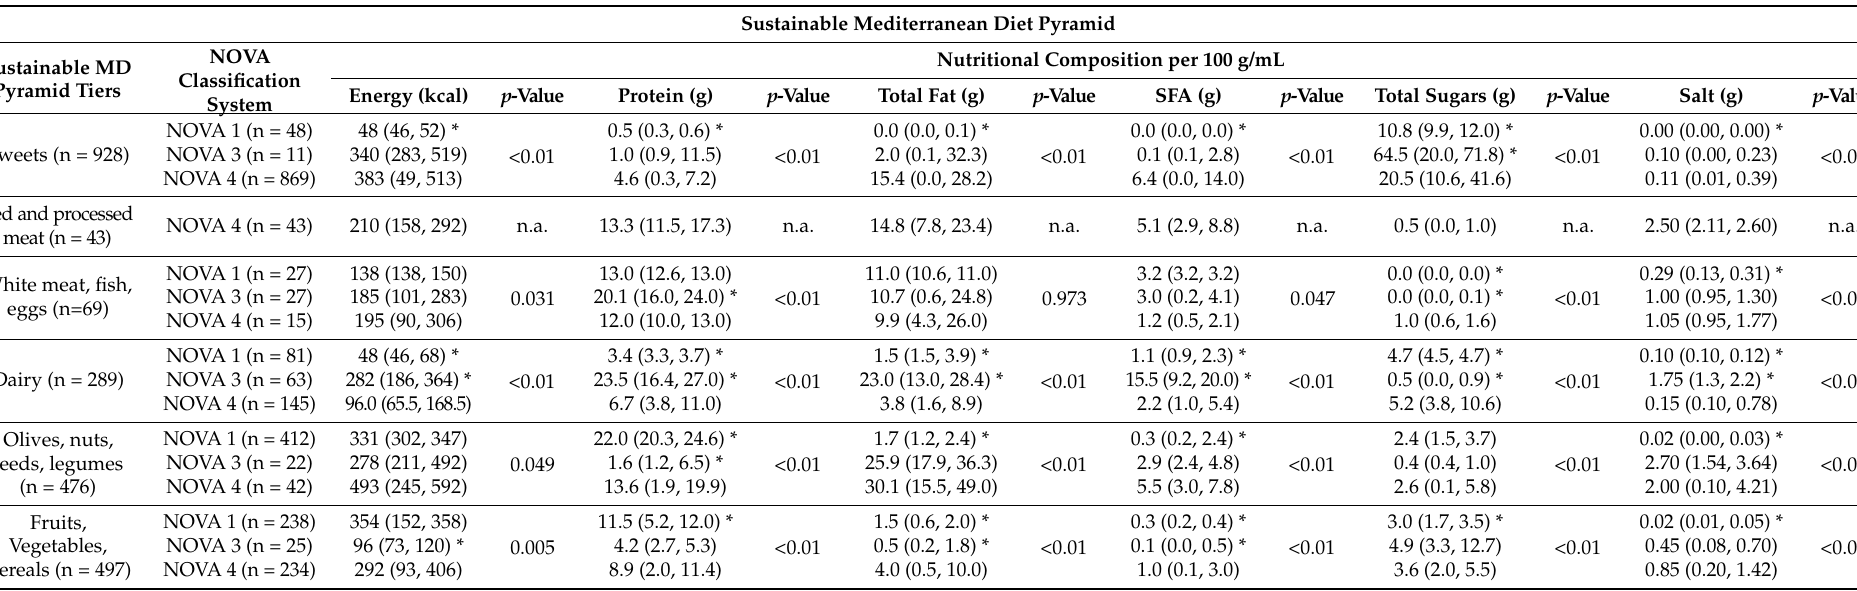
Table 5. Nutritional composition of foods that compose the sustainable Mediterranean diet pyramid, per pyramid tier and per NOVA group. Sustainable Mediterranean Diet